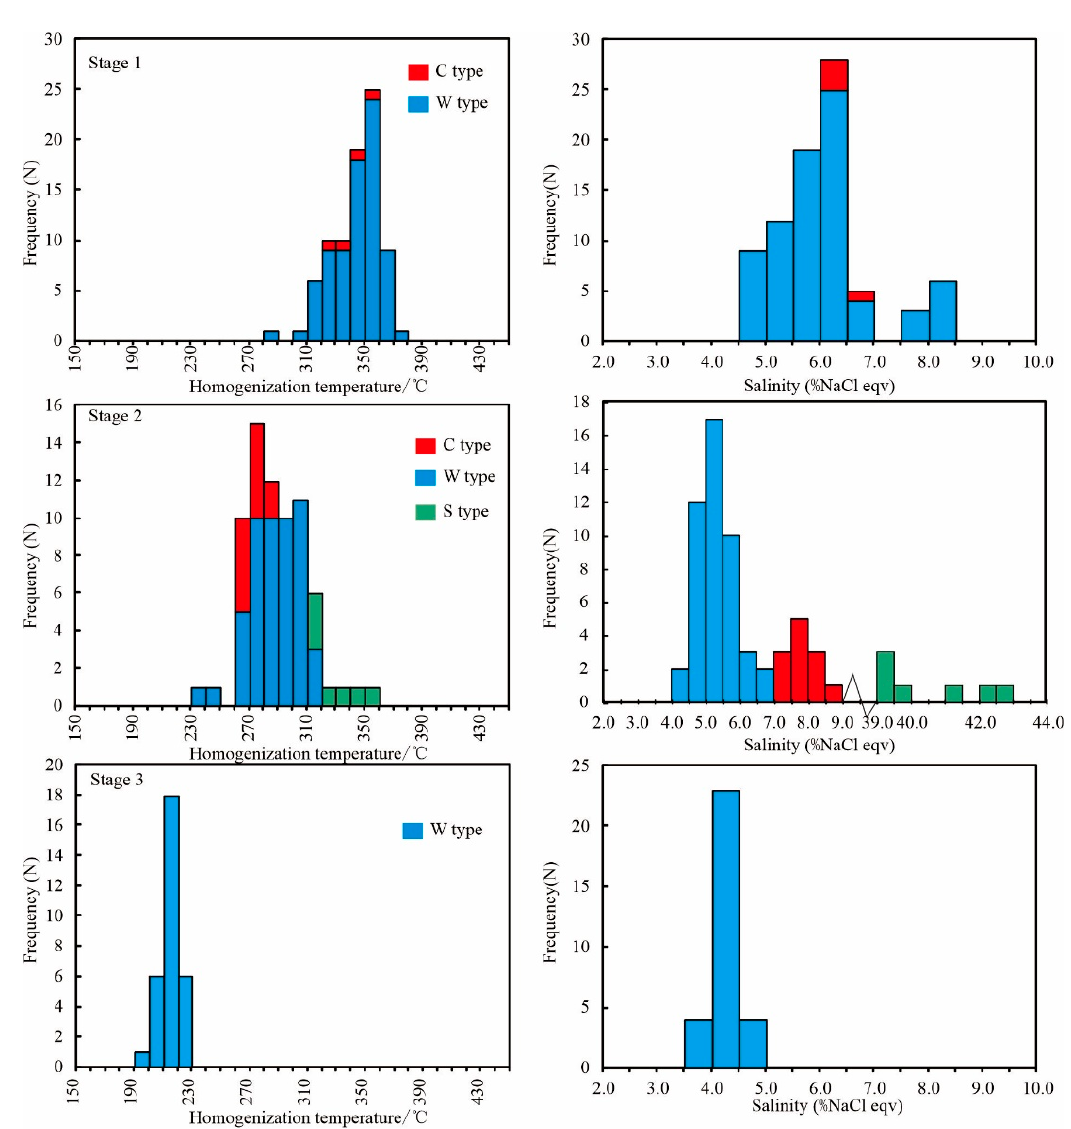
Figure 6. Histograms of homogenization temperatures and salinities of fluid inclusions in different stages of quartz in the Reshui Mo deposit.